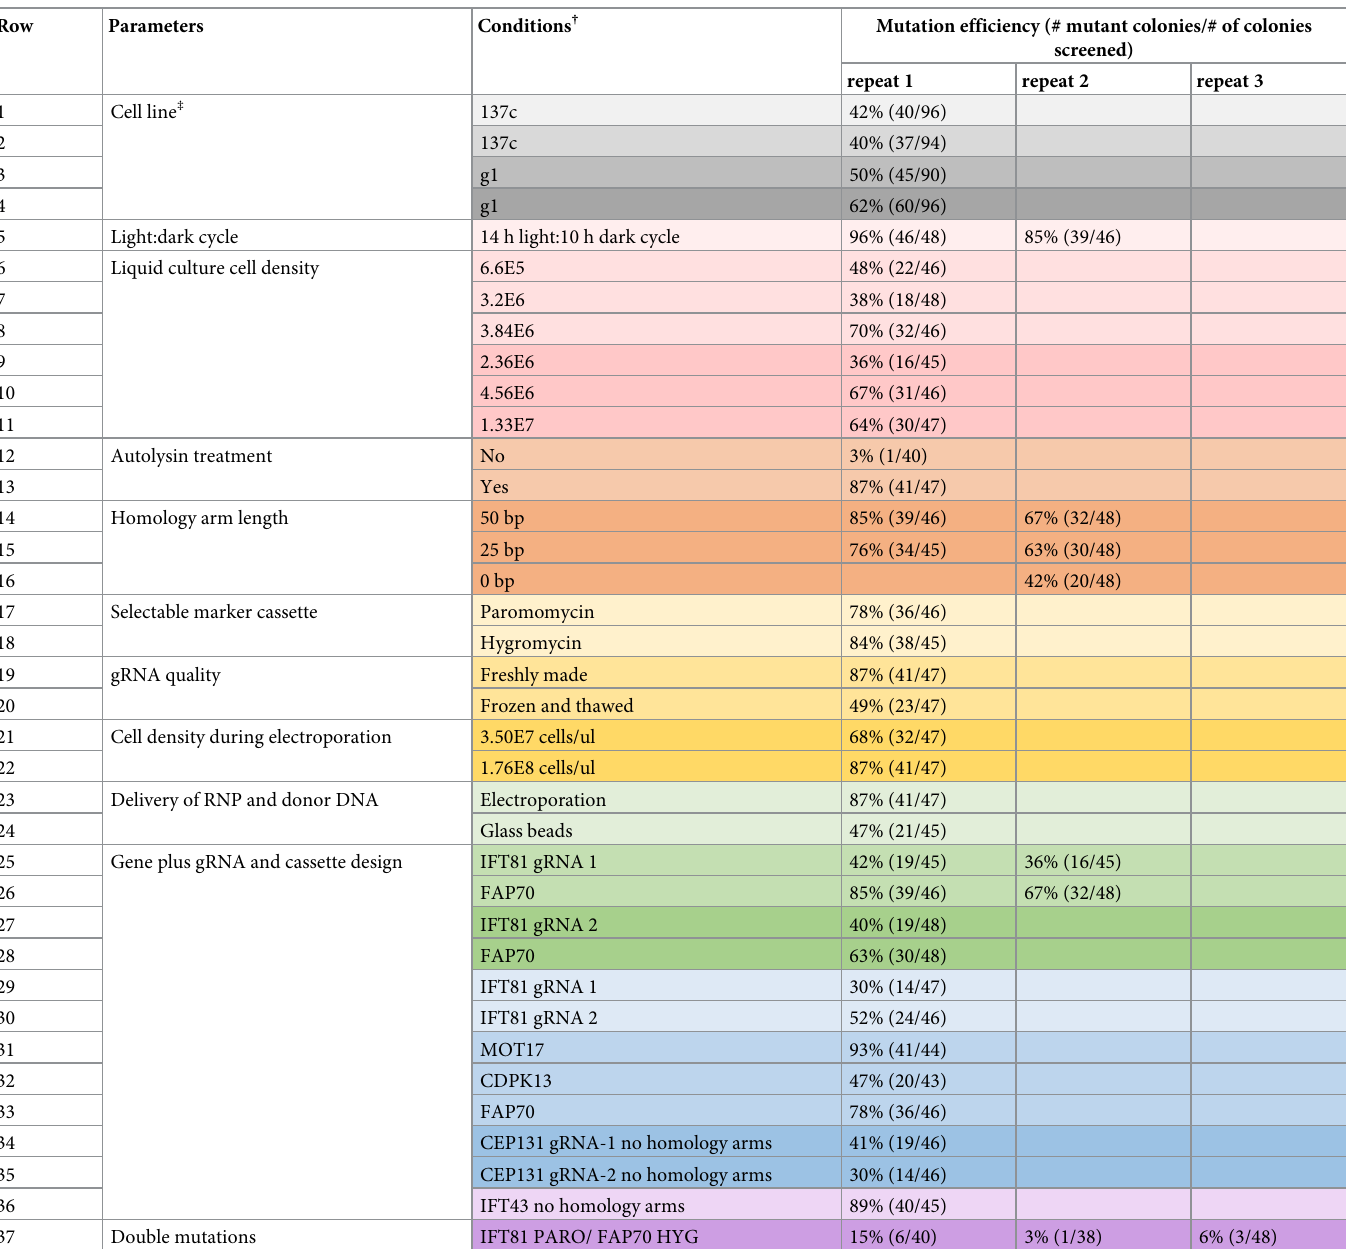
Table 1. Summary of experiments and results �